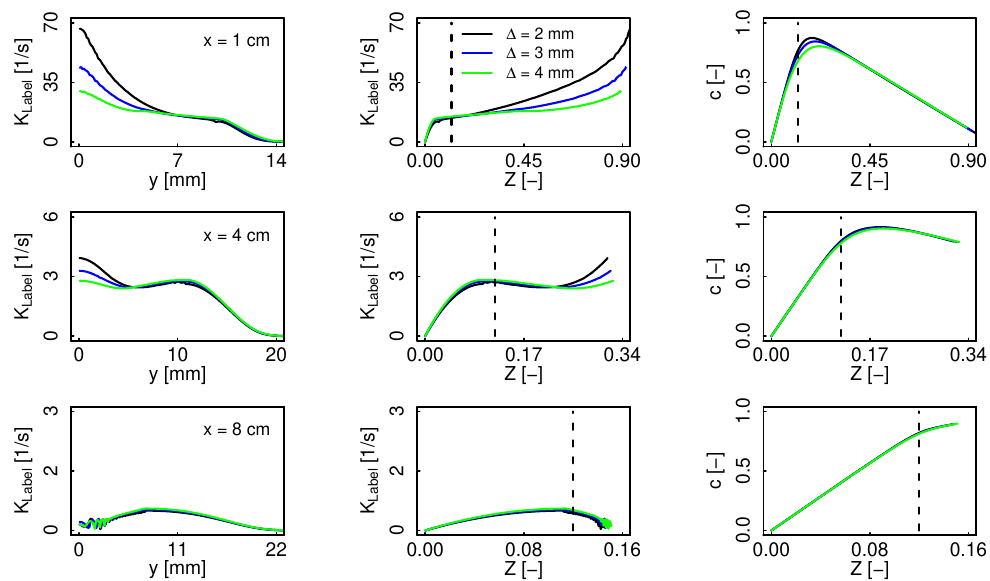
Figure 8. Strain rate and progress variable radial profiles in physical and mixture fraction space. Solid lines radial profiles, vertical dashed line Z st